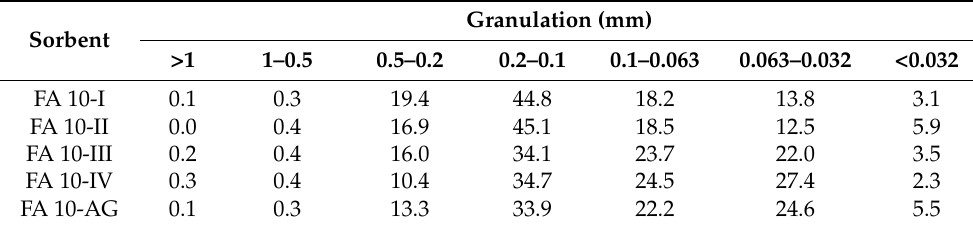
Table 2. Fly ash particulate size distribution.